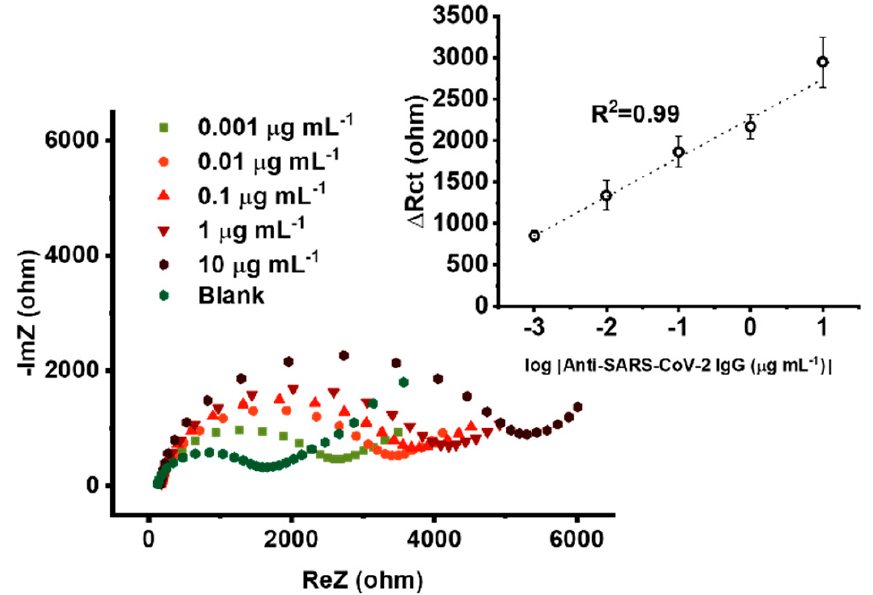
Figure 6. EIS (Nyquist plots) for different concentrations of anti-SARS-CoV-2 IgGs using amplification mode and the corresponding calibration plot (n = 4).